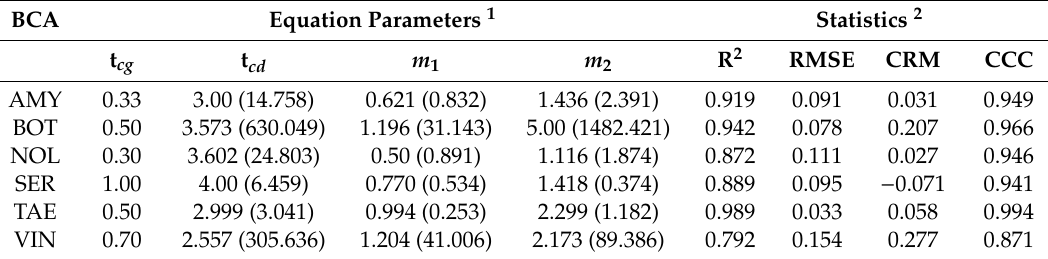
residual mass (CRM), concordance correlation coefficient (CCC).